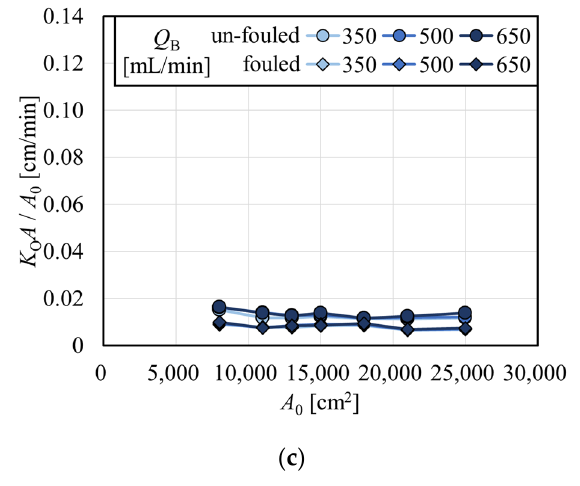
Figure 8. Overall mass transfer-area coefficient divided by A 0 ( K O A / A 0 ) for ( a ) creatinine, ( b ) vitamin B 12 , and ( c ) inulin.